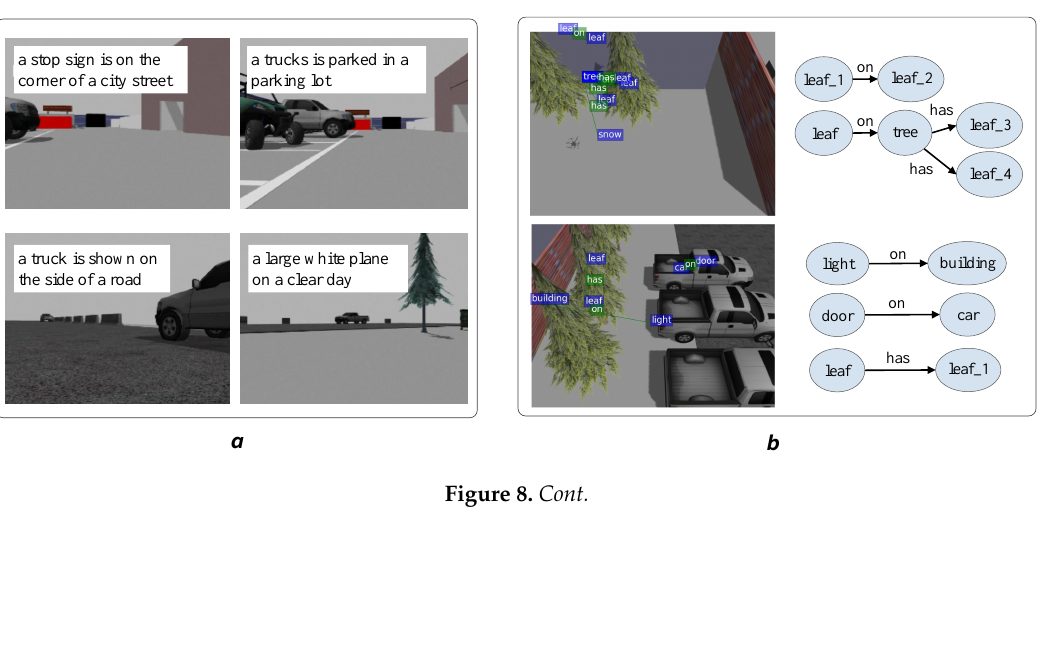
Table 2. Generated plan for Part 2 of the scenario.